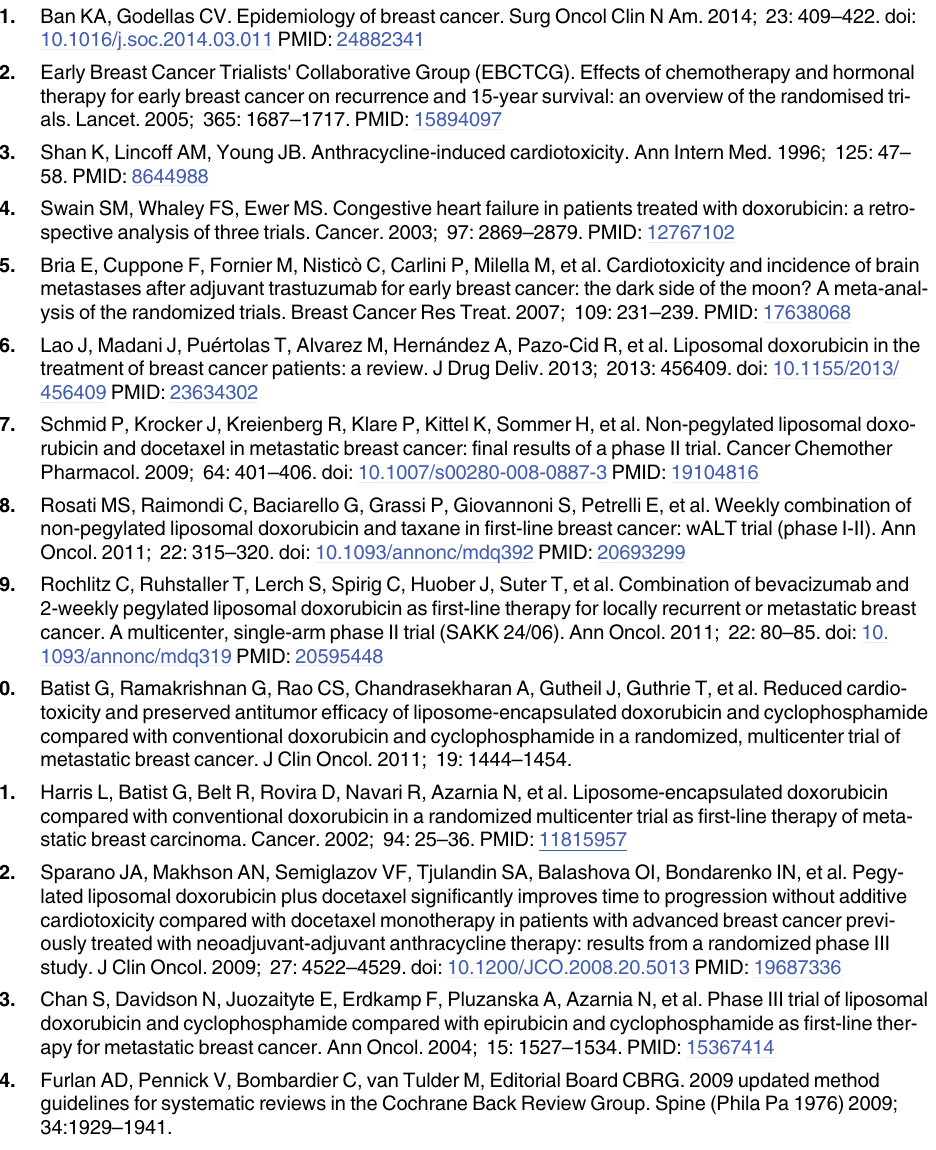
S1 Table. Methodological quality of the included studies based on the 12-items scoring sys- tem. S2 Table. Characteristics of the Studies Included in this